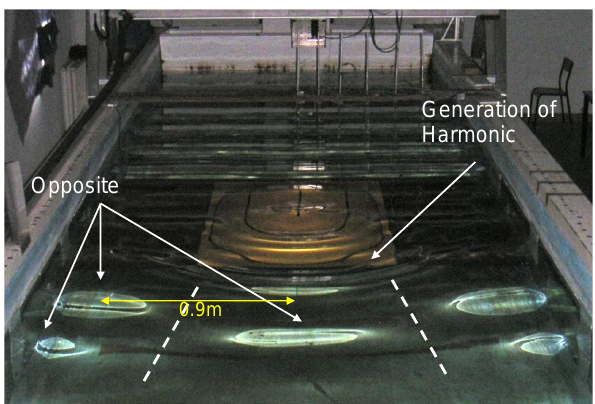
Fig. 7: Photograph of the free surface for run 8, T=0.6s